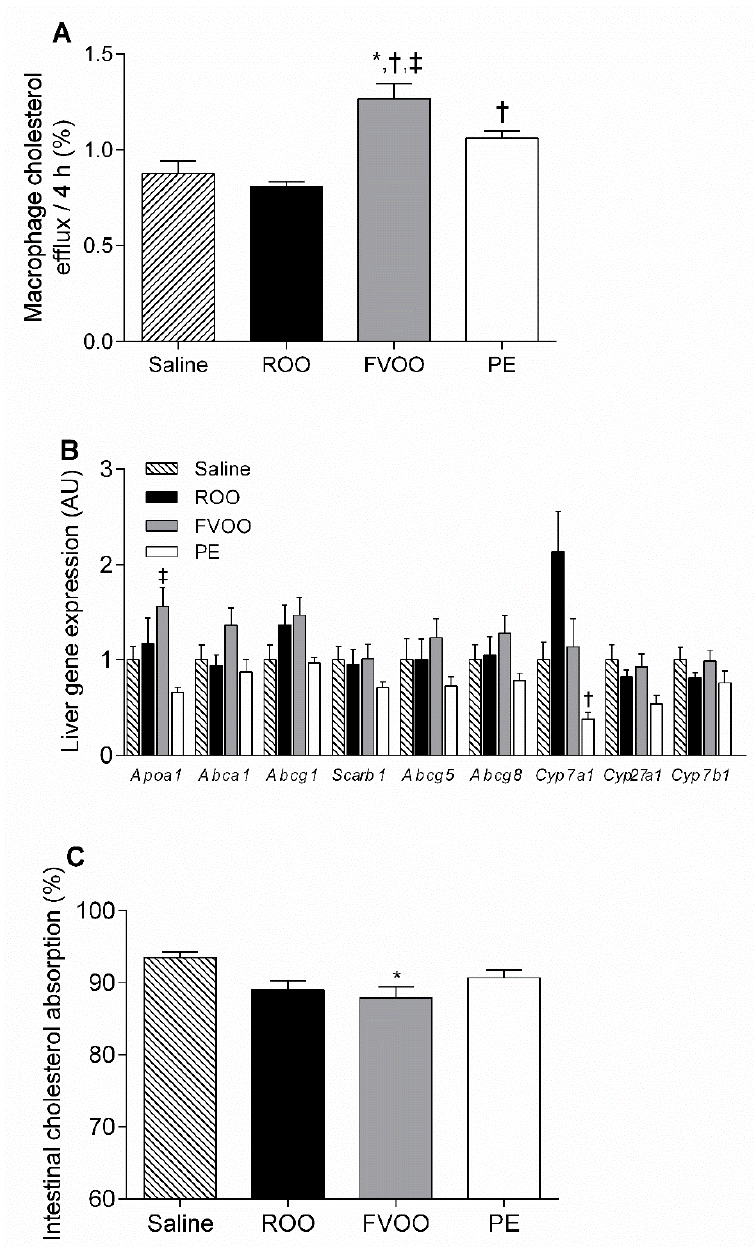
Figure 2. FVOO and its phenolic compounds upregulate macrophage cholesterol e ffl ux but did not a ff ect liver gene expression profile or intestinal cholesterol absorption. ( A )